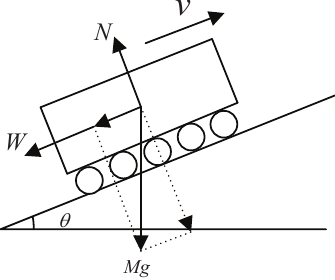
Figure 6. Force condition of urban rail train on the